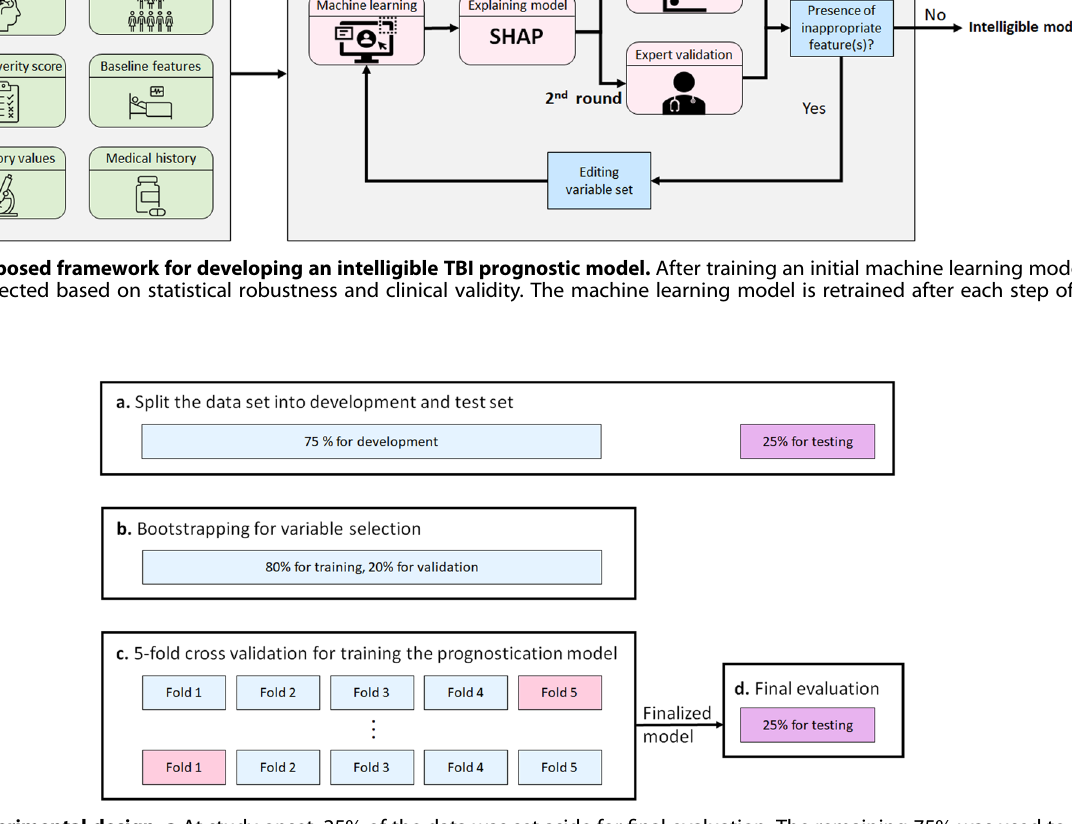
Fig. 6 The experimental design. a At study onset, 25% of the data was set aside for fi nal evaluation. The remaining 75% was used to develop the model, either in b the bootstrap step for variable selection, or c training the prognostic model using 5 fold cross-validation.